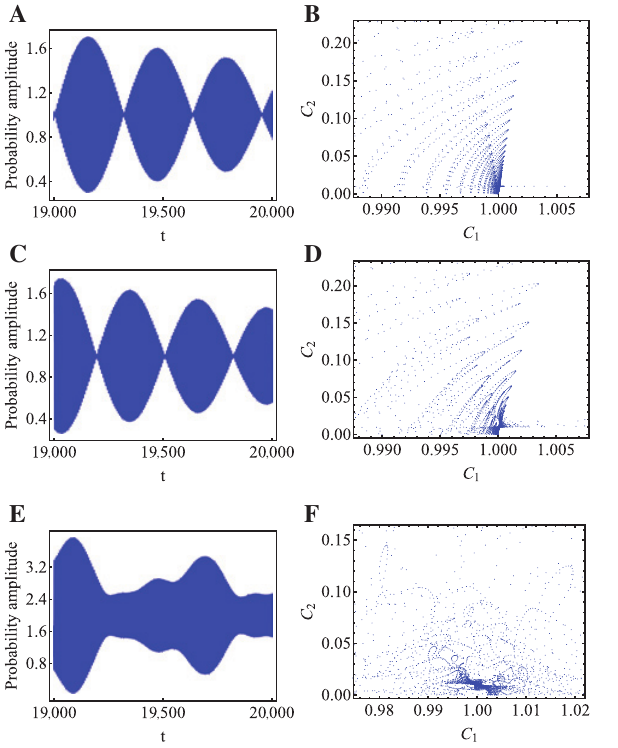
and the Poincare 1